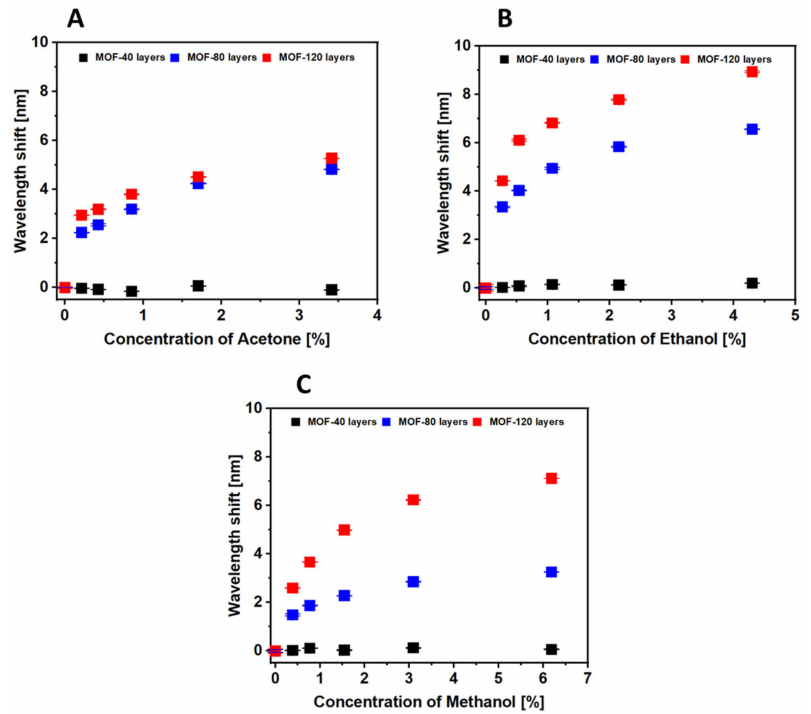
Figure 8. Dynamic response of the peak position of the optical fibre sensor with 40 (black trace), 80 (blue trace) and 120 coating cycles (red trace) of HKUST-1 to different concentrations of ( A ) acetone, ( B ) ethanol and ( C )